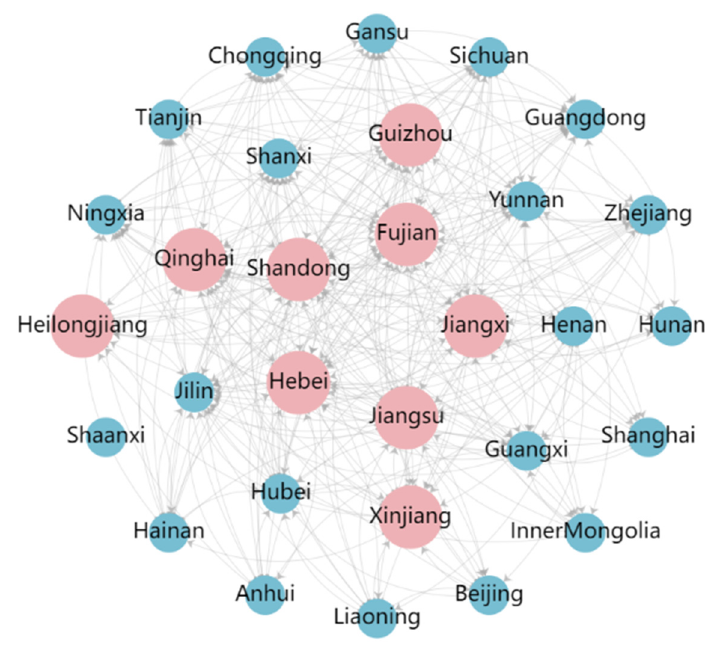
Figure 8. Network diagram corresponding to betweenness centrality.